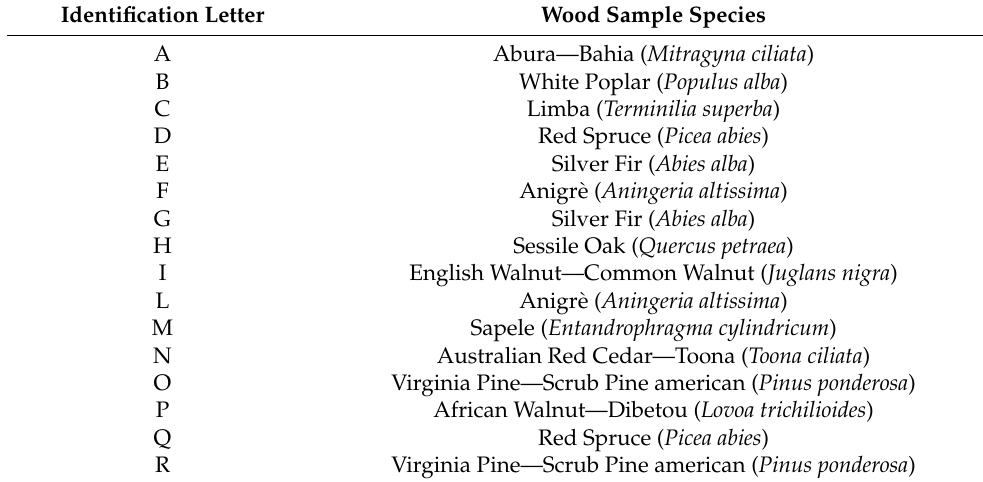
Table 1. Wood denominations of species analyzed in this work (right column) with the associated letter on the left to identify